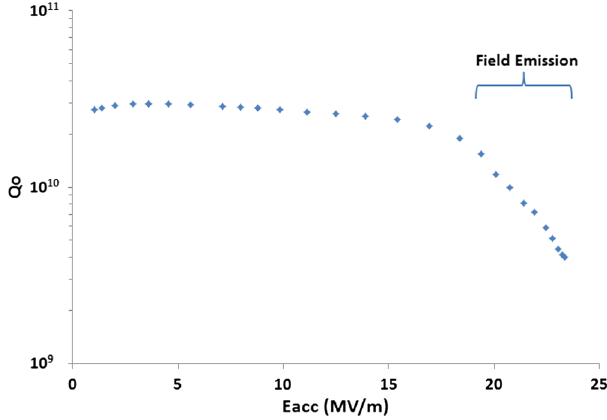
FIG. 5. Radio-frequency results of the “ TB9R1025 ” ILC cavity at 1.7 – 1.8 K after HEP þ 50 μ m VEP at 6